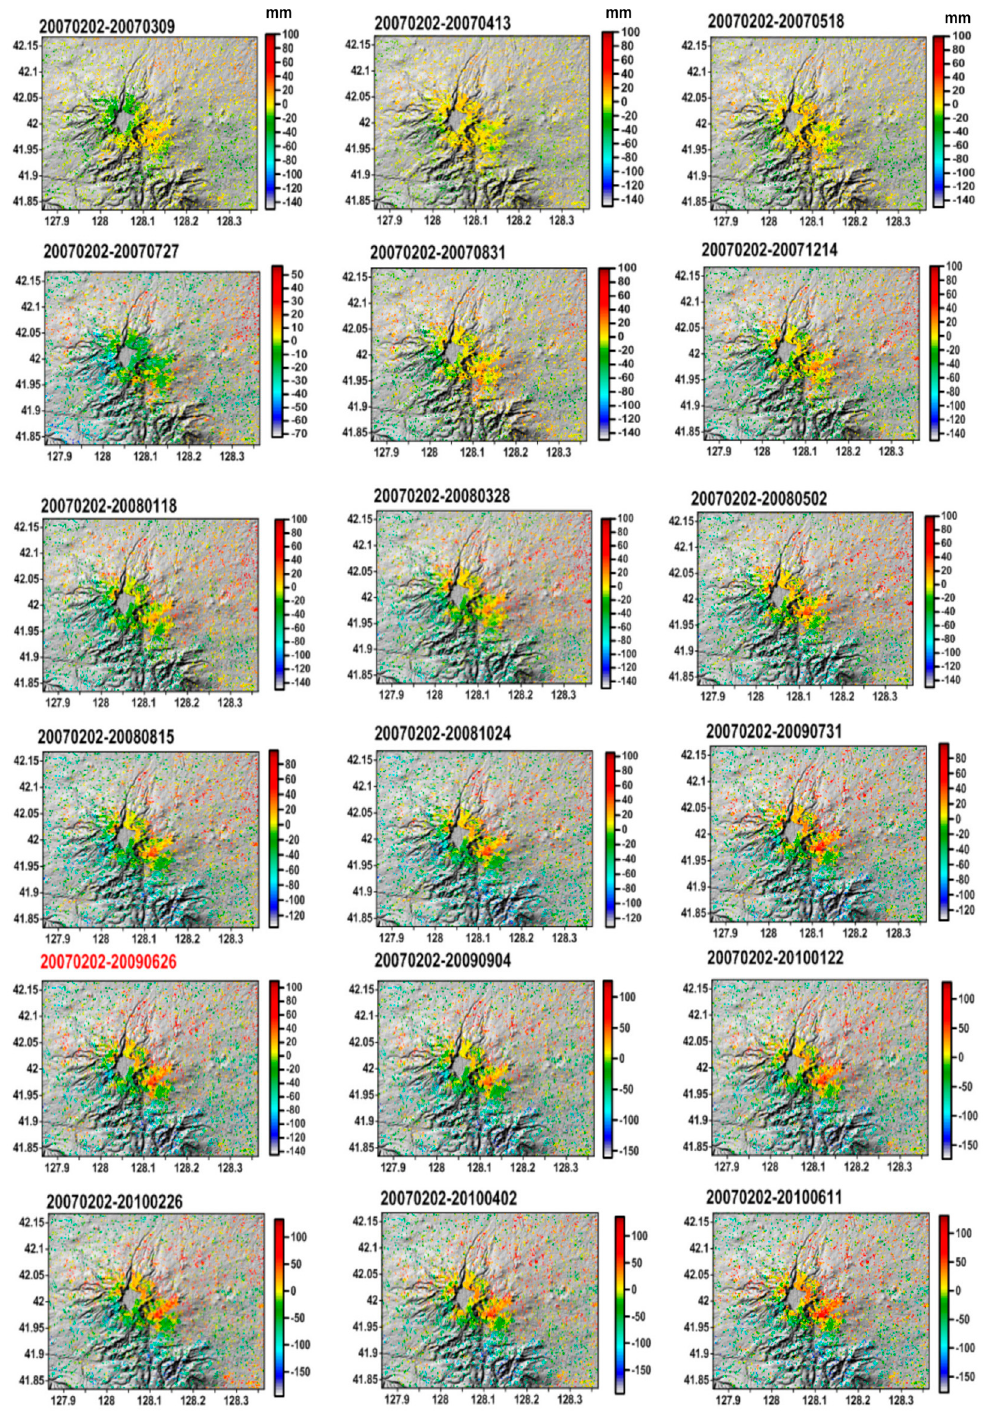
Figure 10. LOS displacement time series over Mt. Baekdu derived from PS-InSAR processing using ENVISAT ASAR images.